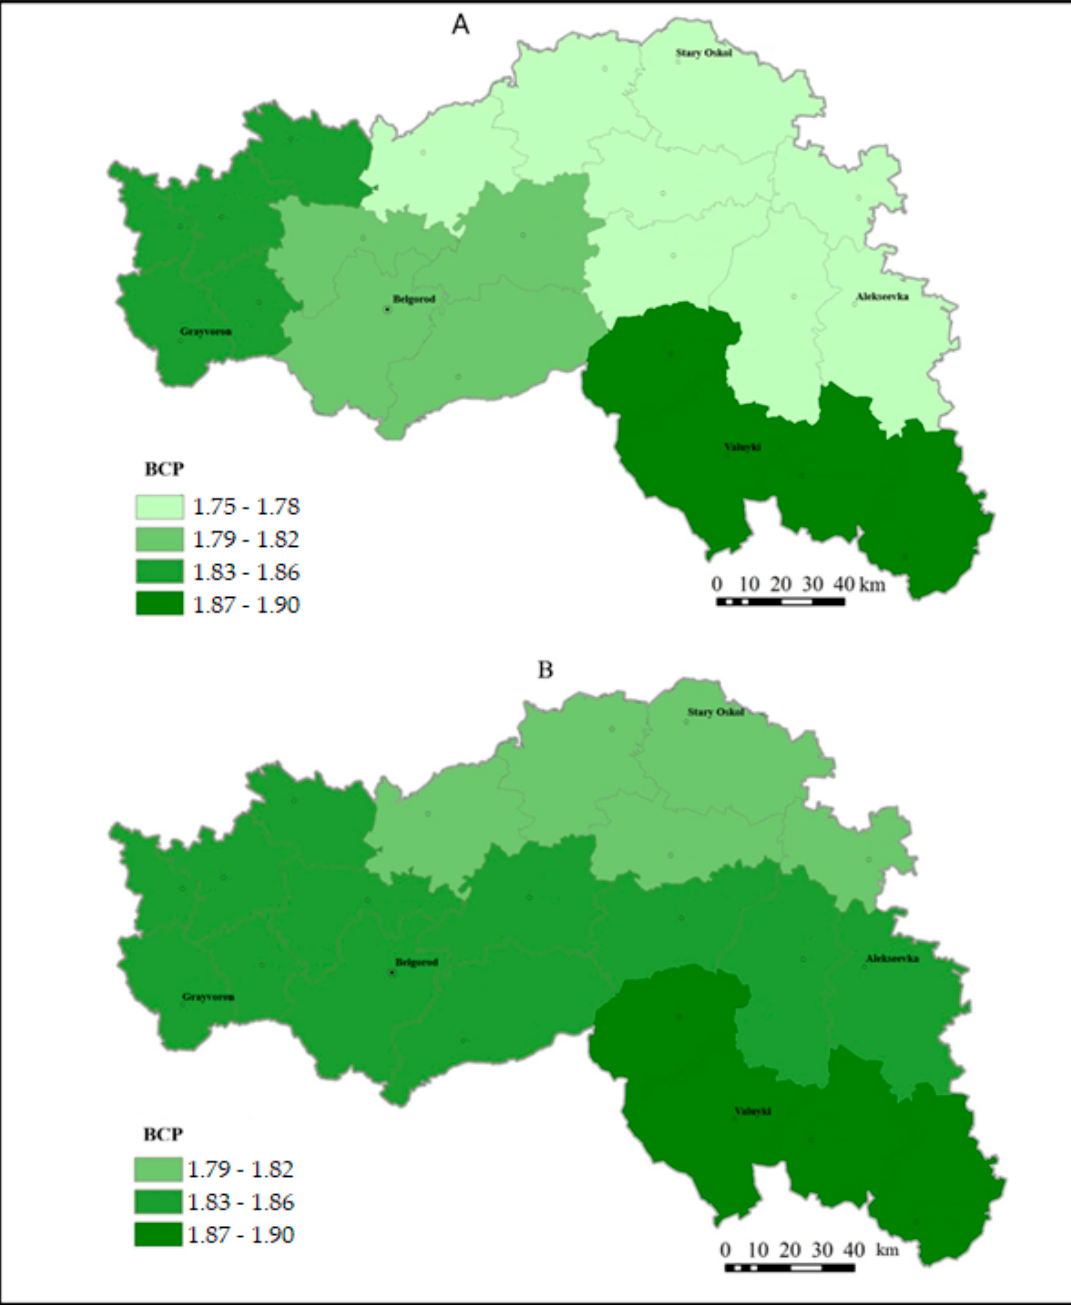
Figure 4. Values of Belgorod Region bioclimatic potential (BCP – mm ◦ C − 1 ) during the periods 1988–2000 ( A ) and 2001–2014 ( B